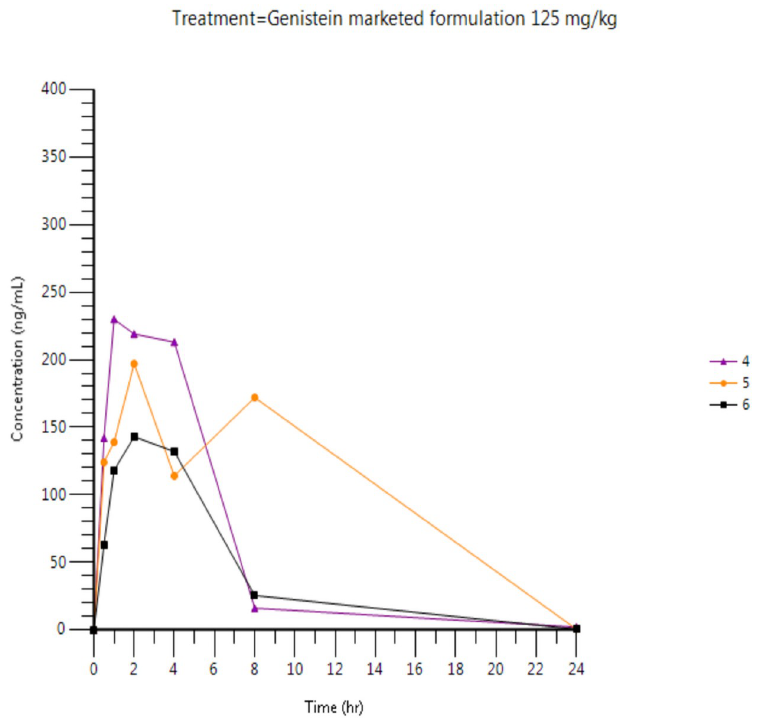
Fig 4. Individual plasma concentration of genistein after oral administration of genistein (125 mg/kg) as marketed formulation in male Wistar rats.